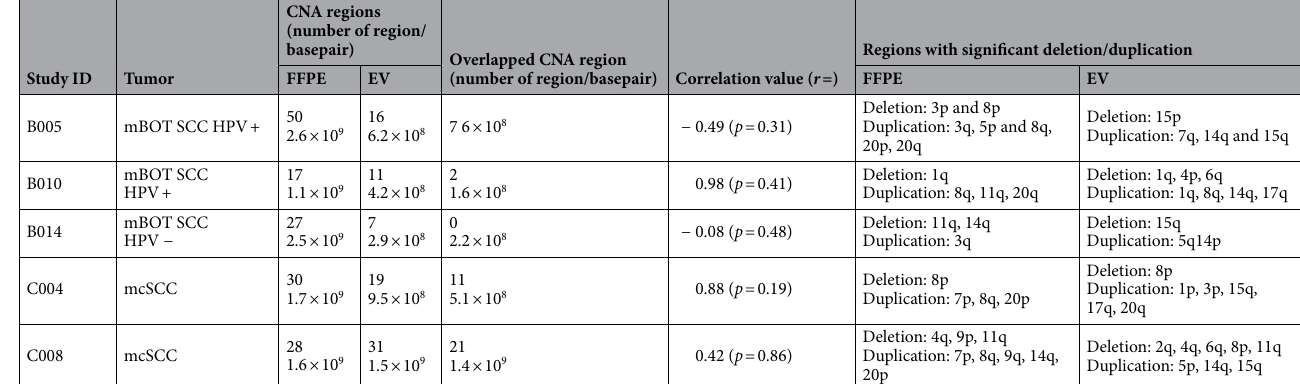
Table 2. CNA region summaries of FFPE/EV samples for each patient, with overlapped CNA regions (in both number of regions and number of basepairs), with correlation value ( r ) and p values. mBOT SCC metastatic base of tongue squamous cell carcinoma, mcSCC metastatic cutaneous squamous cell carcinoma.